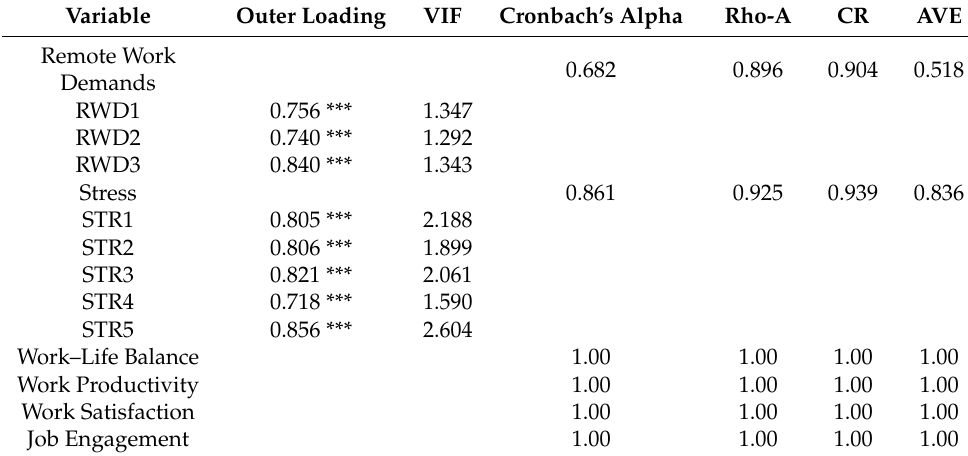
Table 1. Measurement Model: Reliability and validity. Variable